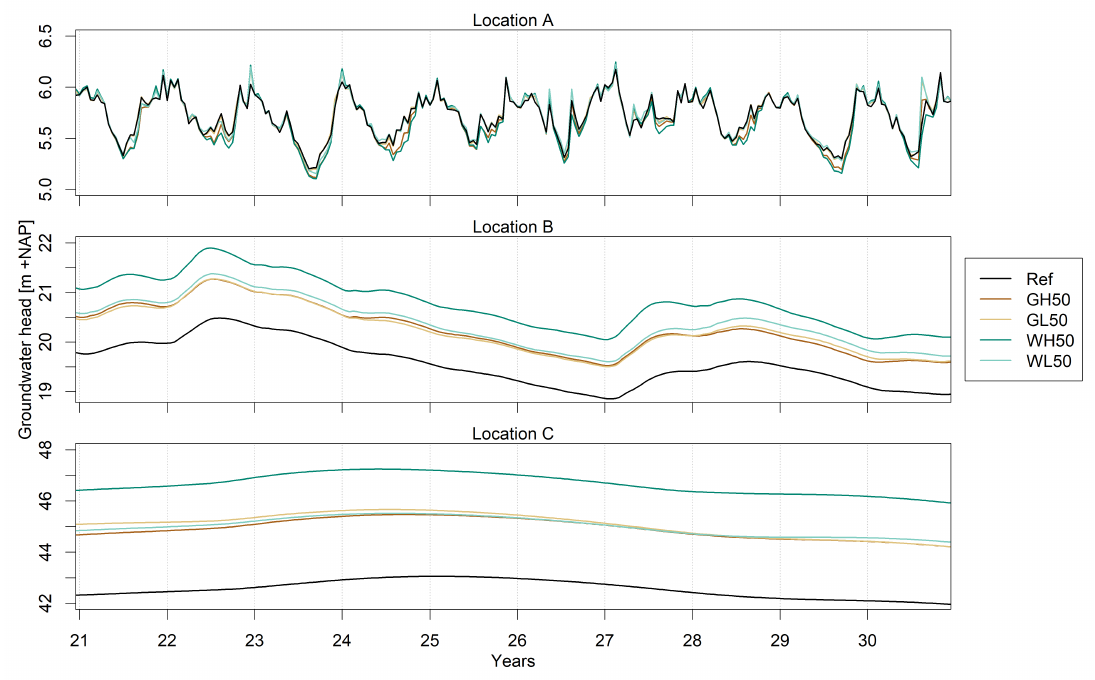
Figure 11. Time series of groundwater levels (m a.s.l) at three selected locations across the southern part of the Veluwe for the last 10 years of the reference period and the climate